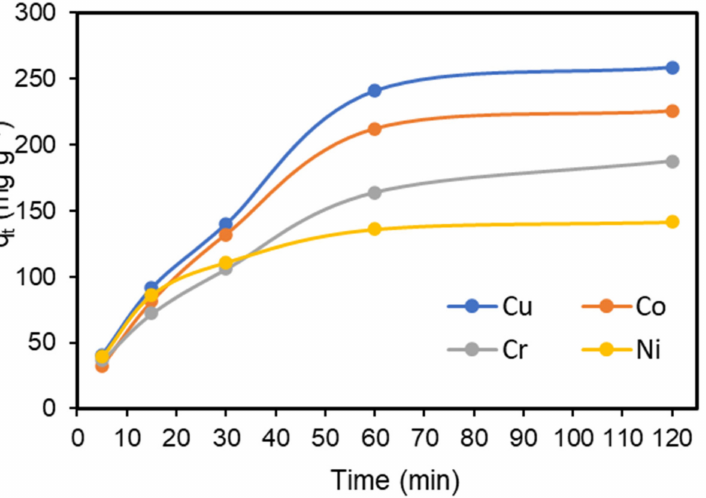
Figure 3. The effect of different contact time on the adsorption capacity of selected heavy metal ions by poly(amidoxime)